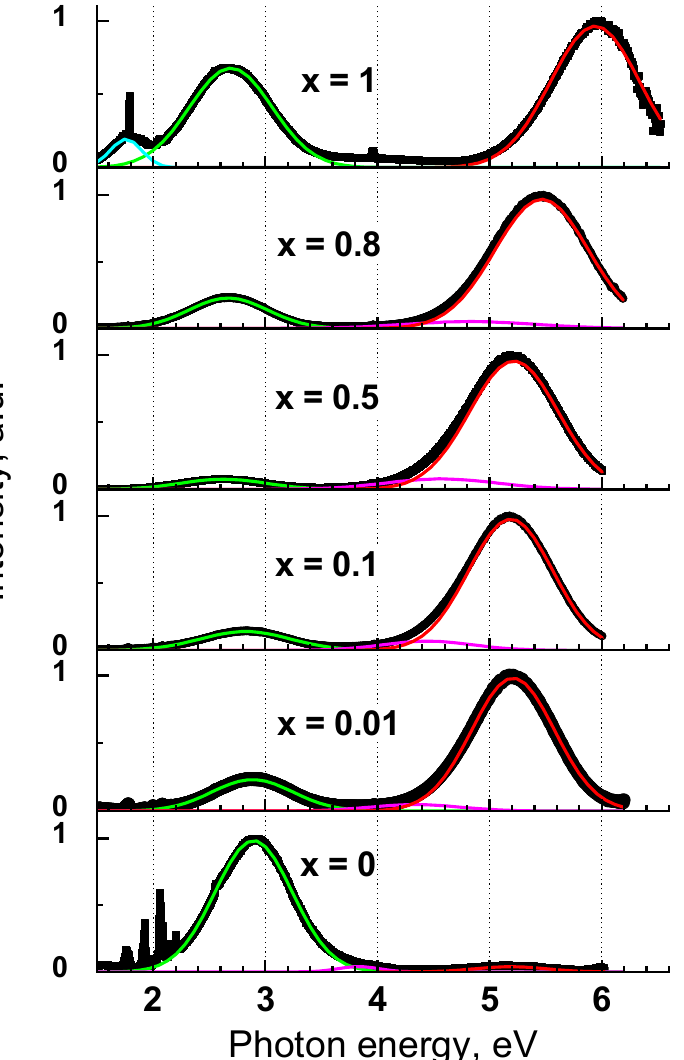
Figure 3. Photoluminescence spectra of Y 1 − x Sc x PO 4 at E ex = 7.75 eV (160 nm), T = 300 K. The Gaussian fit of the emission bands is presented with colored thin curves.